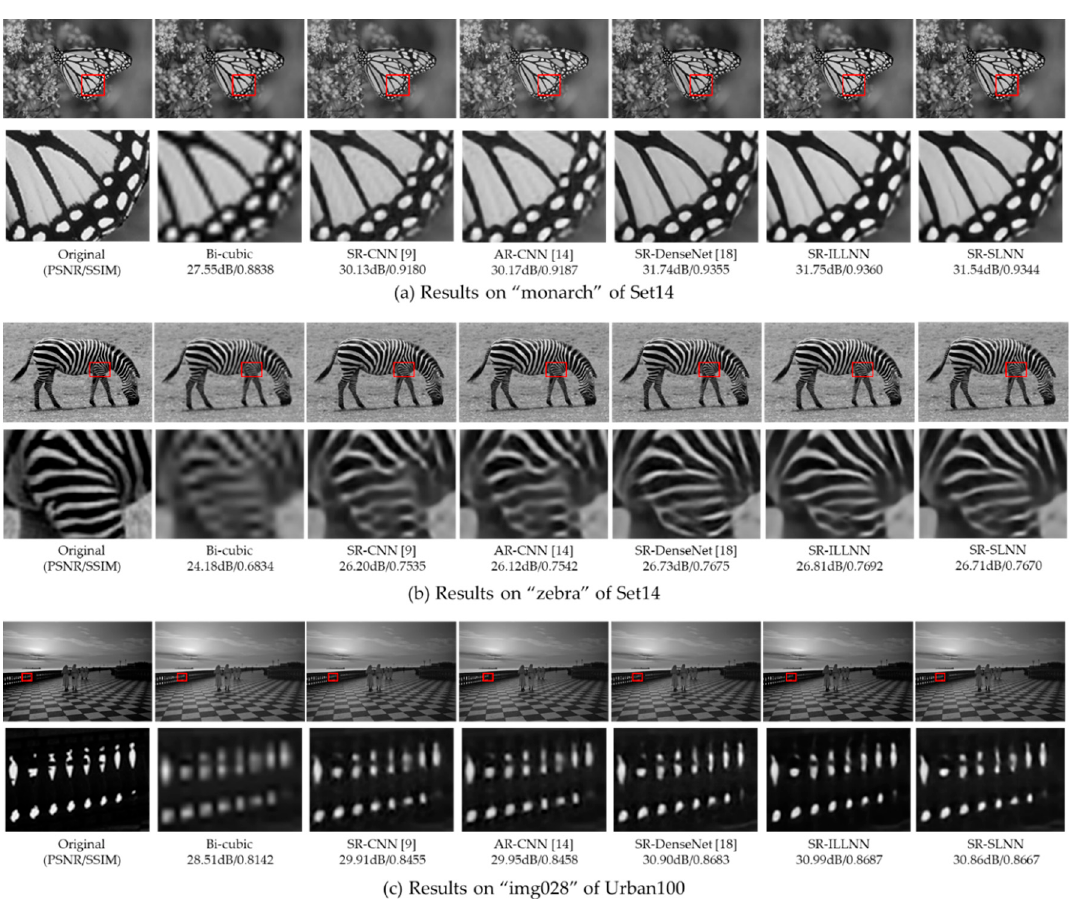
Figure 7. Comparisons of subjective quality on test dataset. ( a ) Results on “monarch” of Set14. ( b ) Results on “zebra” of Set14. ( c ) Results on “img028” of Urban100.